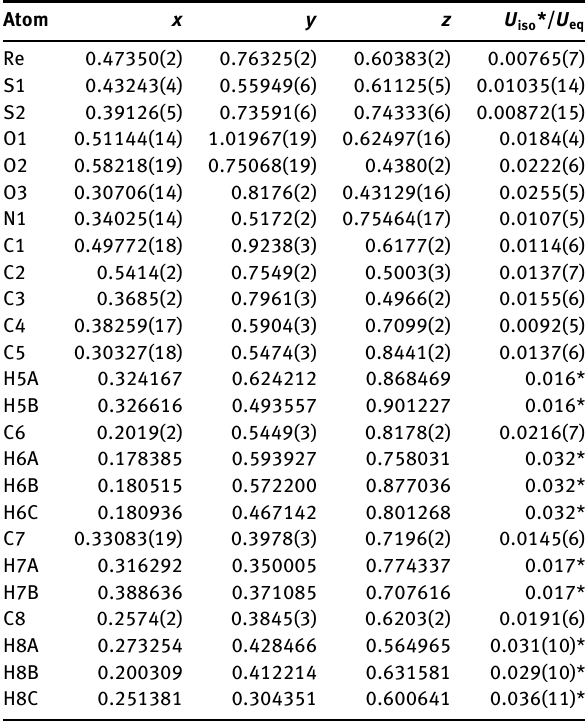
Table 2: Fractional atomic coordinates and isotropic or equivalent isotropic displacement parameters (Å 2